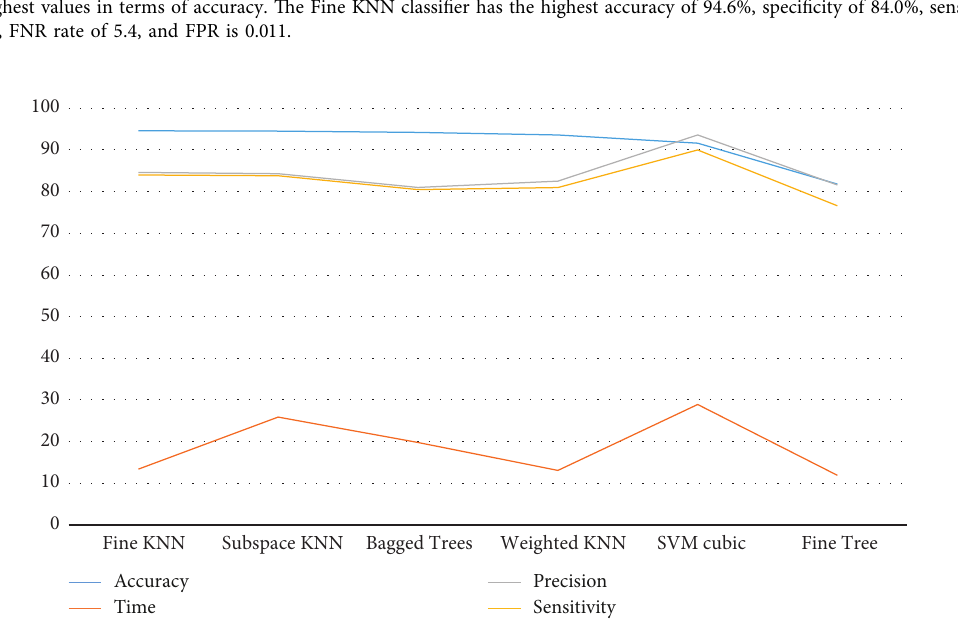
Figure 10: Graphical representation of classification methods in terms of accuracy and time for experiment 2.